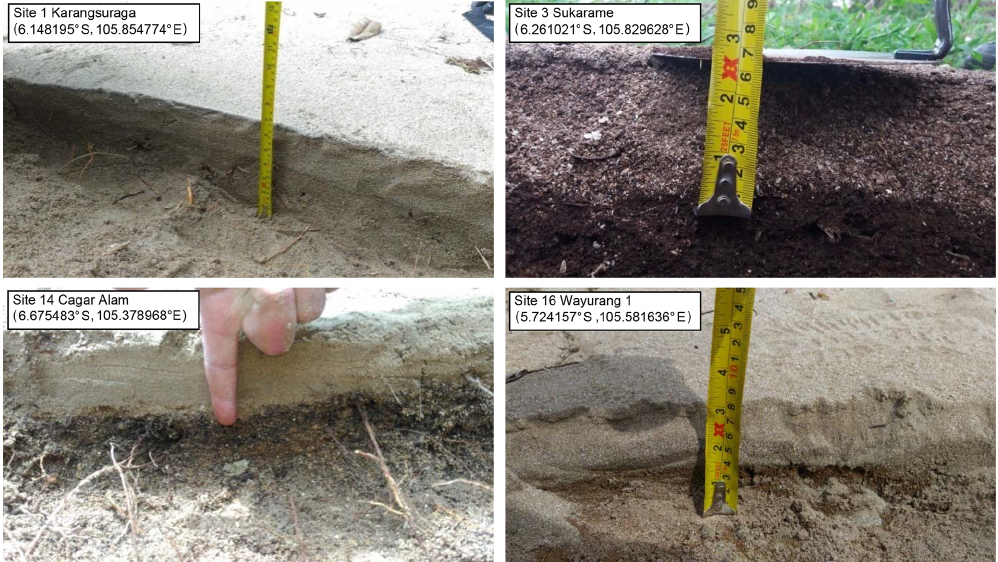
Figure 5. Tsunami sediment deposits; test pits were made to measure the deposit